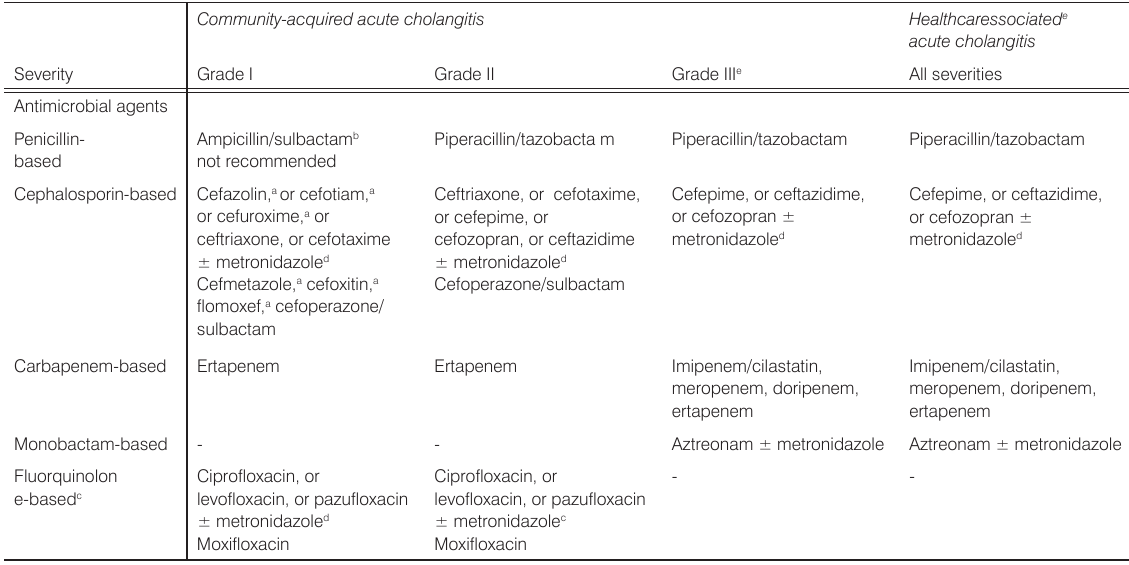
Table 2. Antimicrobial Recommendation for Acute Cholangitis from the TG13 [ 30